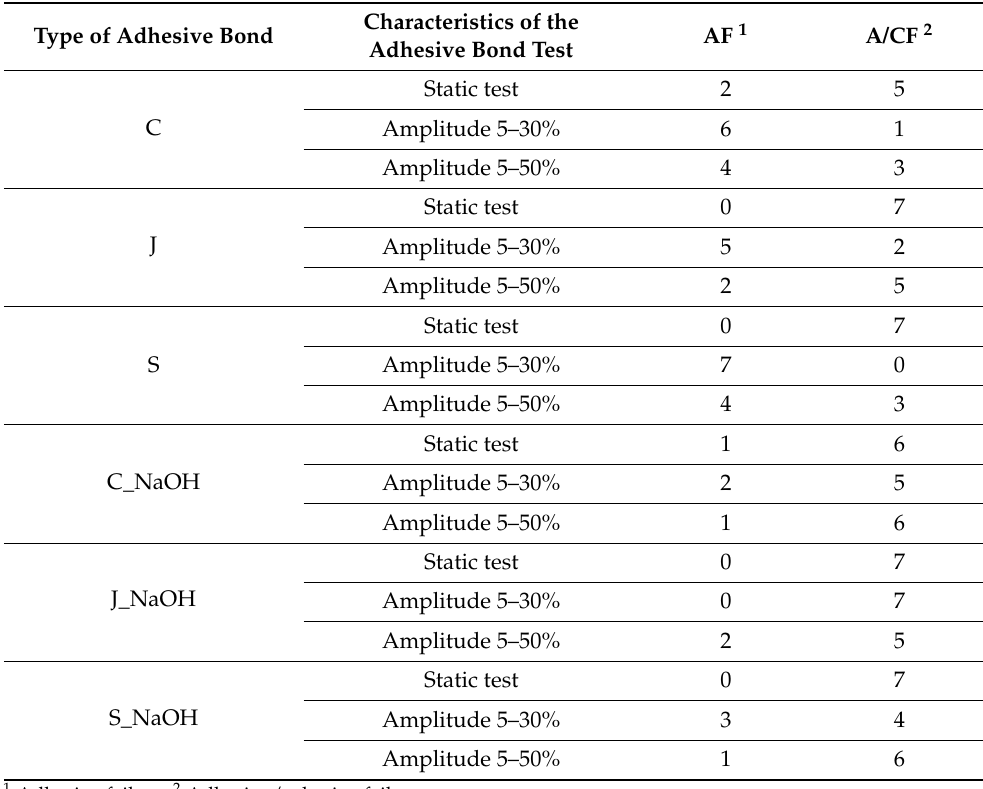
Table 6. Evaluation of the type of failure of individual types of adhesive bonds. Type of Adhesive